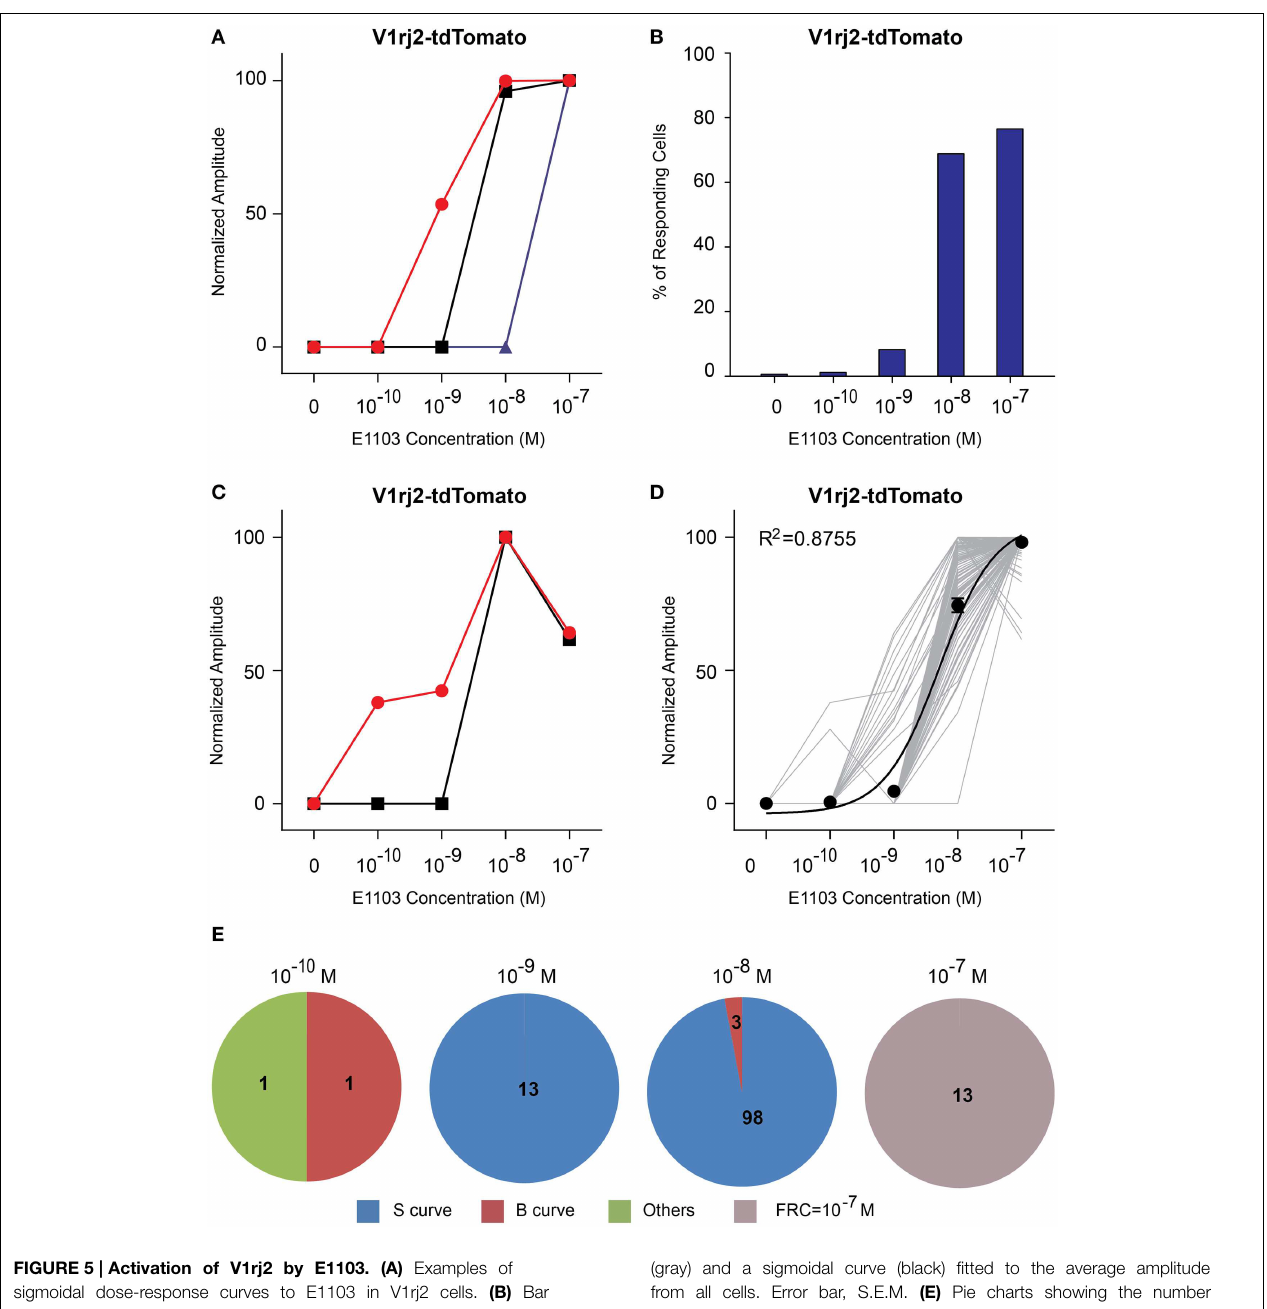
FIGURE 5 | Activation of V1rj2 by E1103. (A) Examples of sigmoidal dose-response curves to E1103 in V1rj2 cells. (B) Bar graph showing the percentage of E1103 activated V1rj2 cells ( n = 129 ). (C) Examples of bell-shaped dose-dependent responses of V1rj2 cells to E1103. (D) Dose-response curves of individual cells